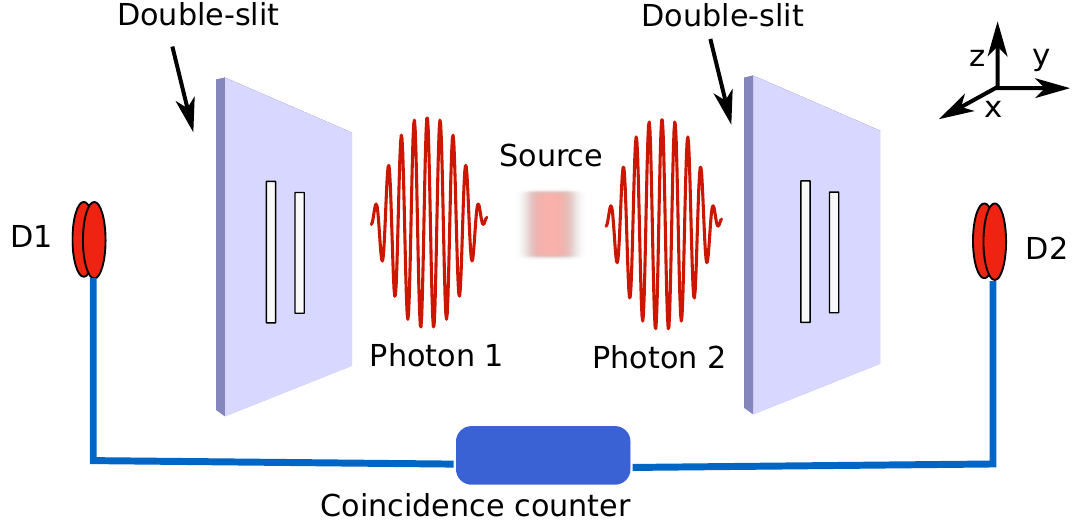
Figure 2: Schematic diagram for the proposed nonlocal biphoton experiment. Photons 1 and 2 e ff ectively move in opposite directions along y -axis. Detectors D1 and D2 move along the x-axis in synchrony such that their x-positions are always the same. They also count the photons in